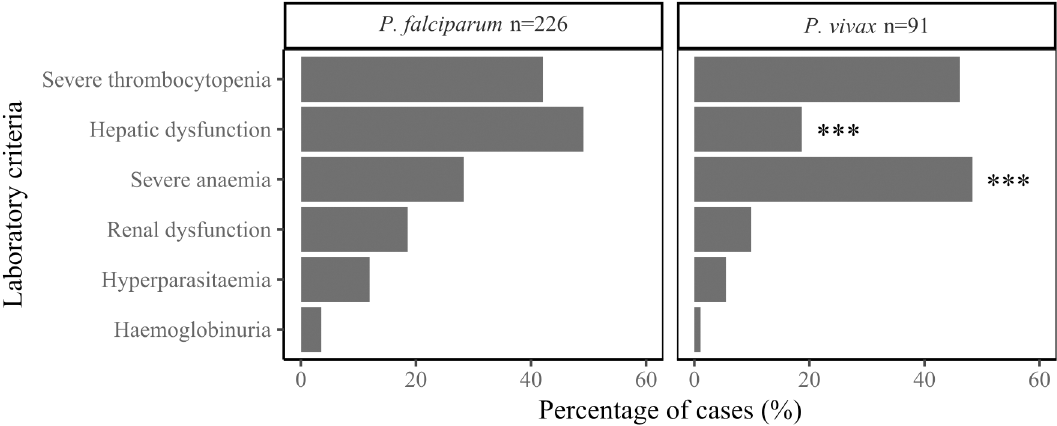
Fig 5. Frequency of laboratory complications in P . falciparum and P . vivax cases. Percentageof malariapatients that presented each of the indicatedWHO/MoH complicatedlaboratorycriterion are shown for each Plasmodium species.